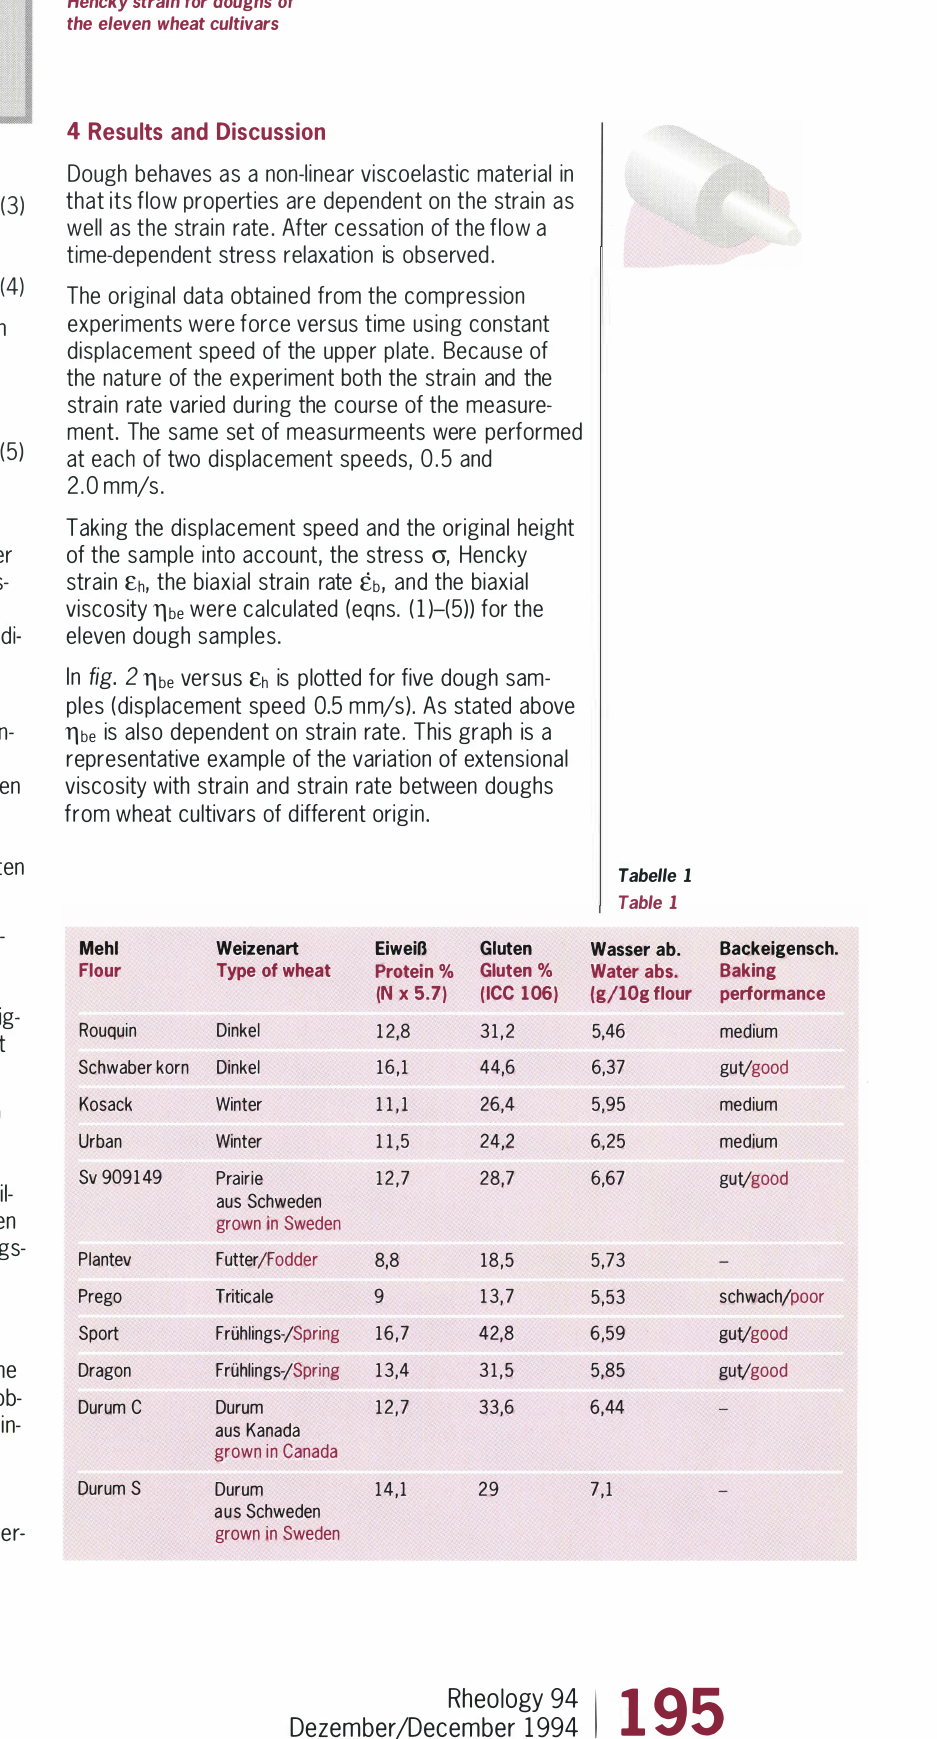
Fig. 3: Apparent biaxial extensional viscosity, ll be. versus biaxial strain rate, fb, at a constant Hencky strain for doughs of the eleven wheat cultivars